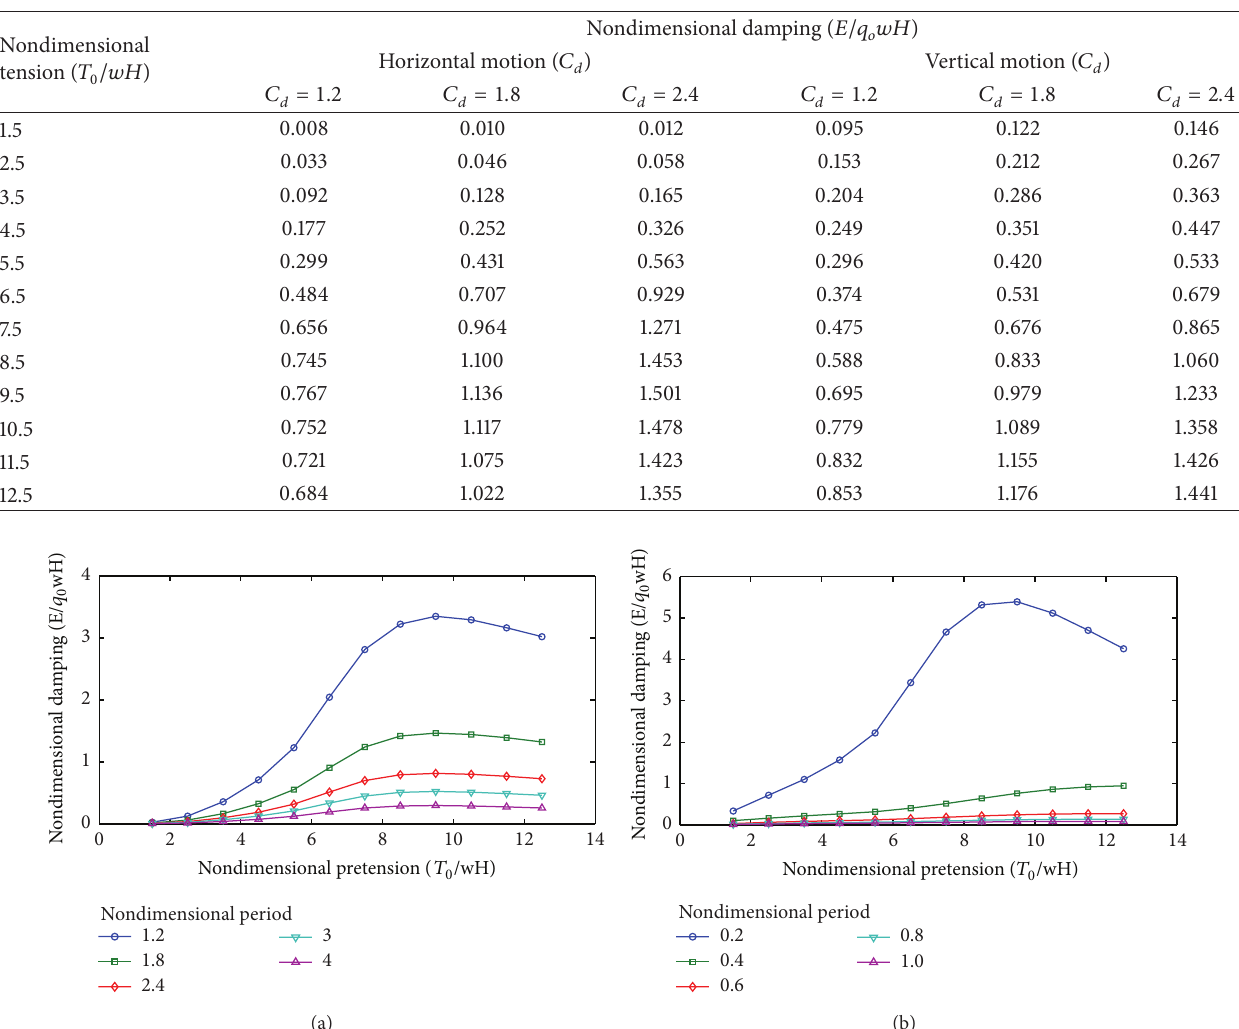
Table 5: Mooring line damping estimation under different drag coefficient.